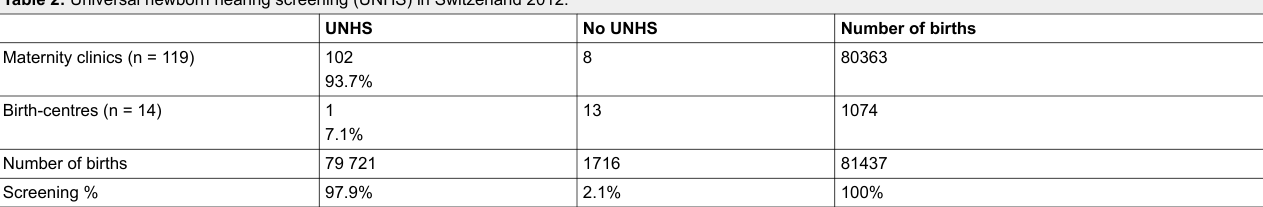
Table 2: Universal newborn hearing screening (UNHS) in Switzerland 2012. UNHS Number of births Maternity clinics (n =